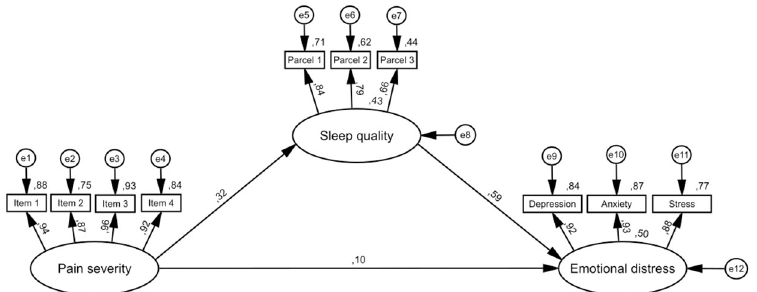
Fig 2. Model 2—Sleep quality on an indirect path between pain severity and emotional distress. N = 468. Rectangles represent observed variables and ovals represent latent variables. All values are standardized coefficients, except for values near variables, which are squared multiple correlations. Error terms of variables are depicted as e1-e16. Control variables (age, gender, ethnicity, employment and marital status, educational level, perceived health, taking sleep medications, taking non-sleep medications and history of sleep disorders) are not depicted to support visual clarity. For sleep quality and sleep hygiene higher scores indicate poorer sleep quality/sleep hygiene.